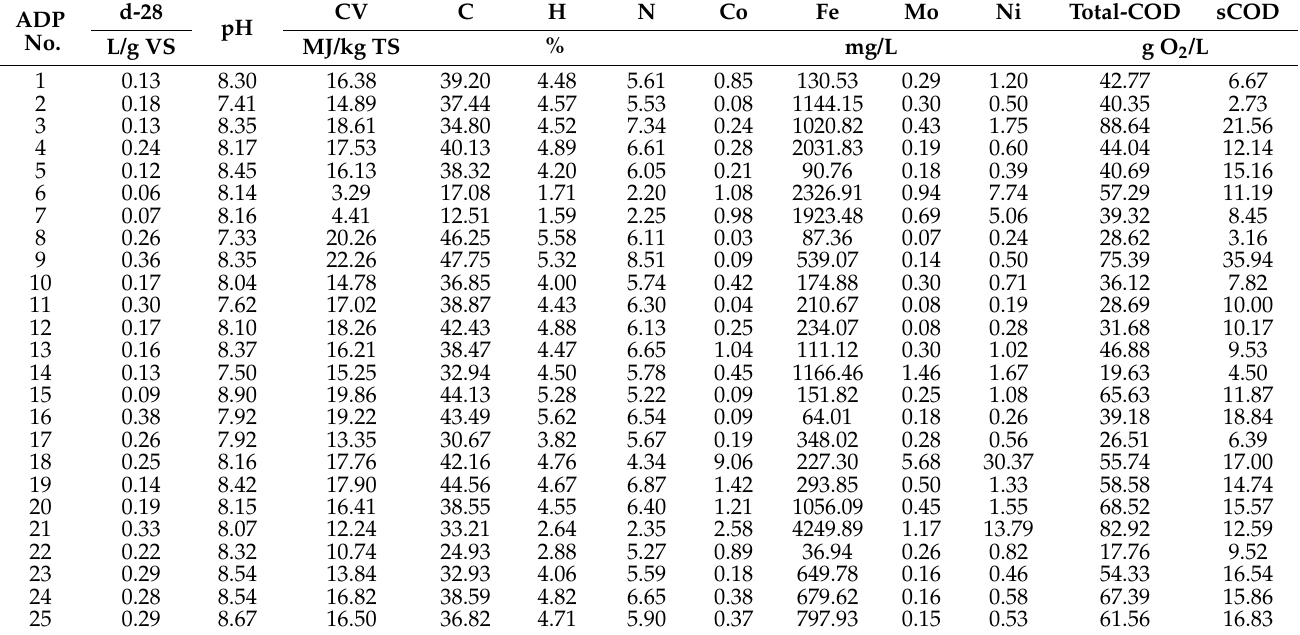
Table 2. RBP test results on day 28 (d-28) and the physicochemical characteristics of 25 samples (Part